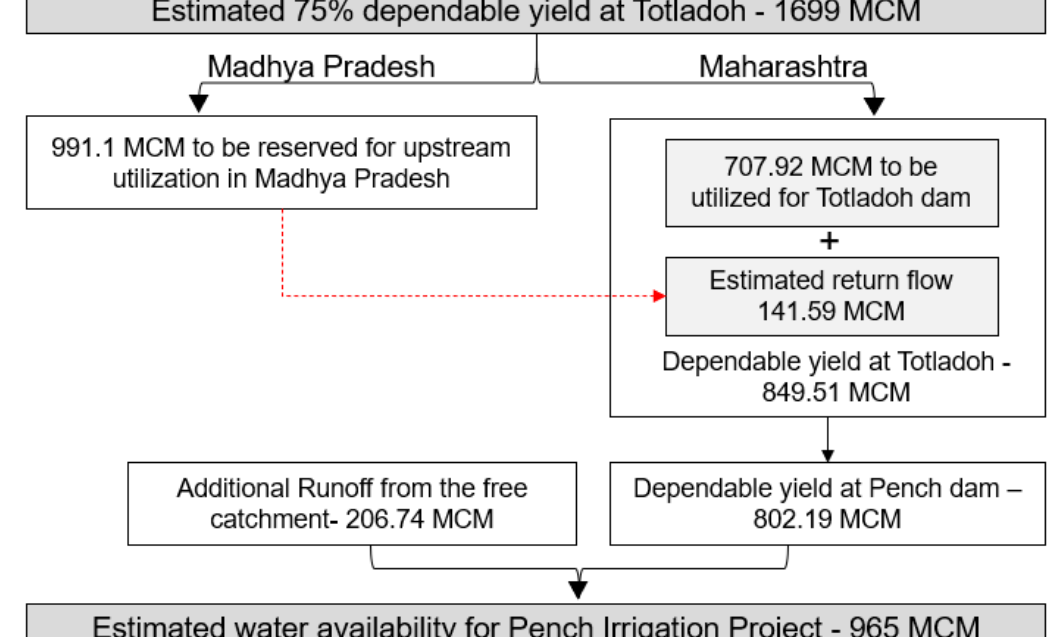
Figure 5. Summary of Pench water-sharing agreement (information source: Reference [109]). MCM = million cubic meters. Table 2. Water-allocation planning for the Pench Irrigation Project, 1996.